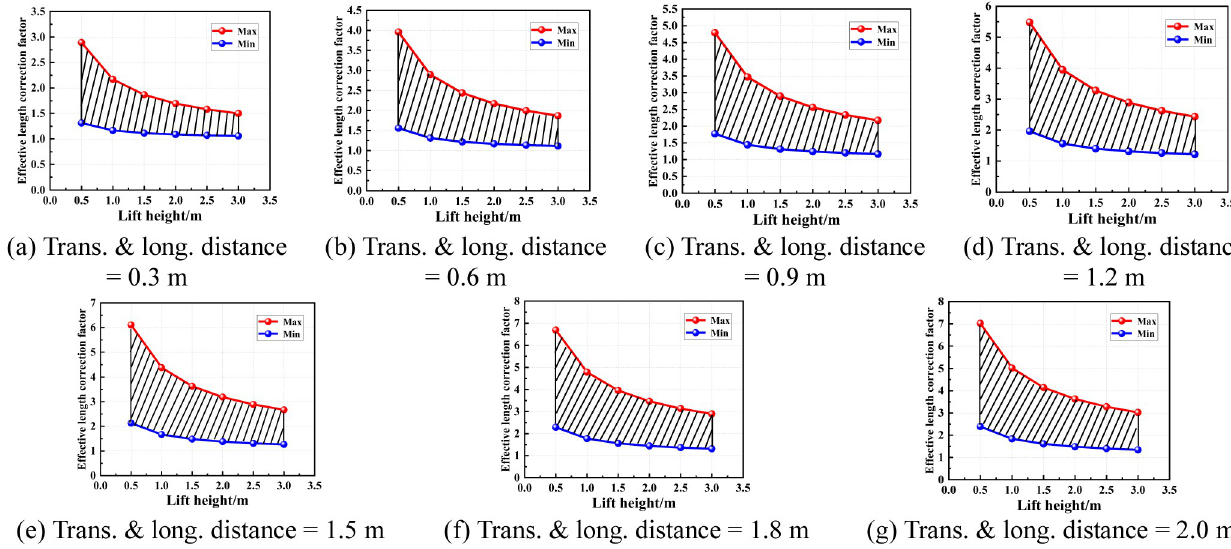
Fig 17. Value areas of the effective length correction factor of condition 2. (a) Trans. & long. distance = 0.3 m. (b) Trans. & long. distance = 0.6 m. (c) Trans. & long. distance = 0.9 m. (d) Trans. & long. distance = 1.2 m. (e) Trans. & long. distance = 1.5 m. (f) Trans. & long. distance = 1.8 m. (g) Trans. & long. distance = 2.0